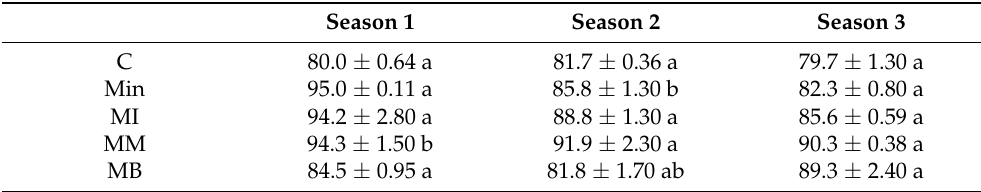
Table 4. Mean ( ± 1 SD) above ground biomass (g) of 3 plants from maize plots near Nairobi Kenya with different fertilizer treatments taken during the mid-growing period of each of the three seasons. Different letters indicate significance at